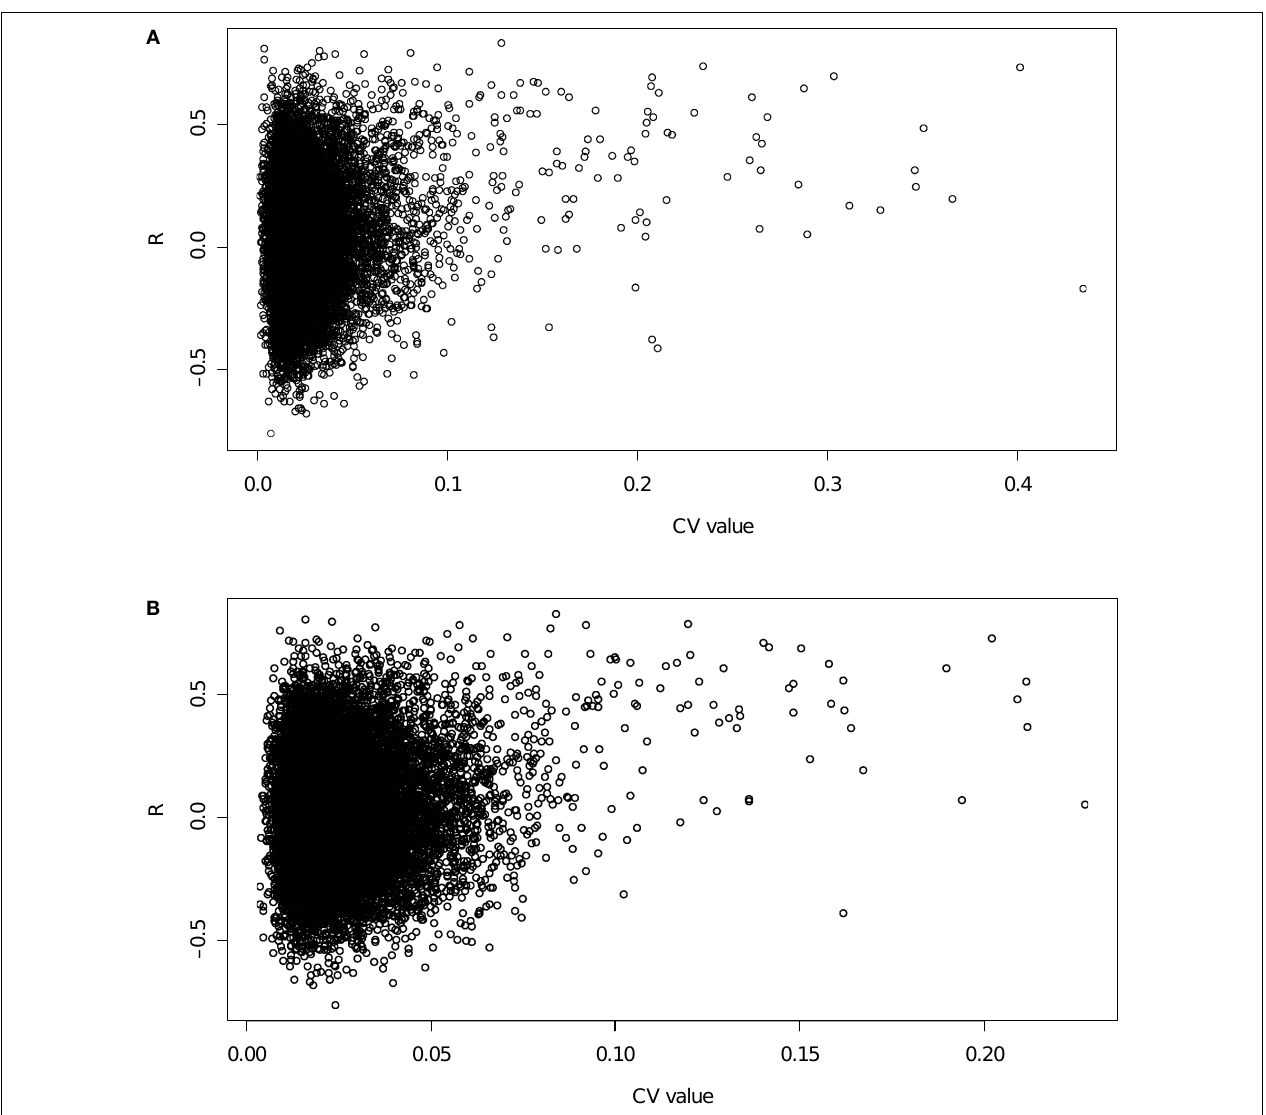
FIGURE 1 | Scatterplot of CV vs showing a positive correlation between CV in the (A) spleen and (B) hippocampus datasets and the correlation between the two tissues.